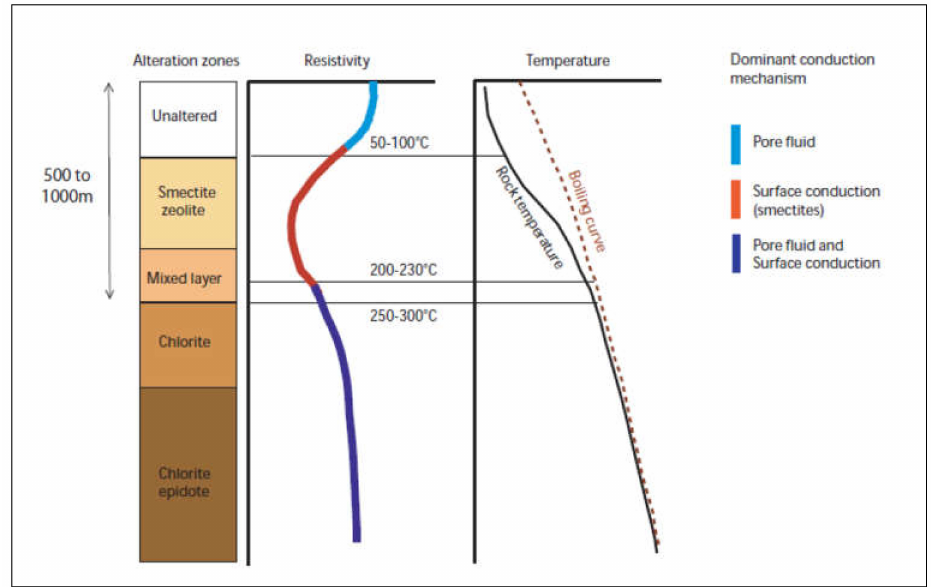
Figure 1. Resistivity structure and alteration of a high-temperature geothermal system in the basaltic crust in Iceland summarized in [3], modified from [5]. Figure